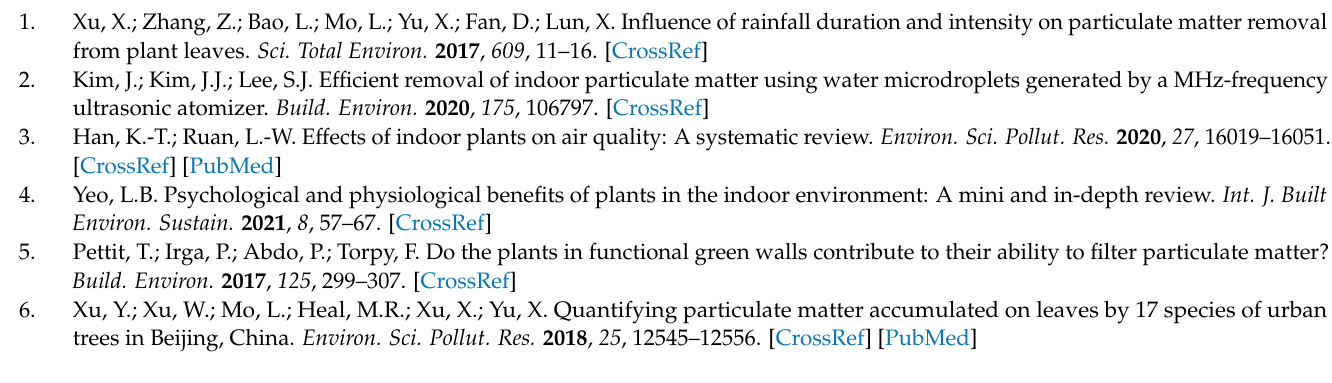
(continuous dark) with drought during 6 days in parallel. The error bars represent standard deviation (S.D.), Figure S3. Removal efficiency of PM2.5, CO 2 , and VOCs by the filter system without plants as control experiment during 6 days. The error bars represent standard deviation